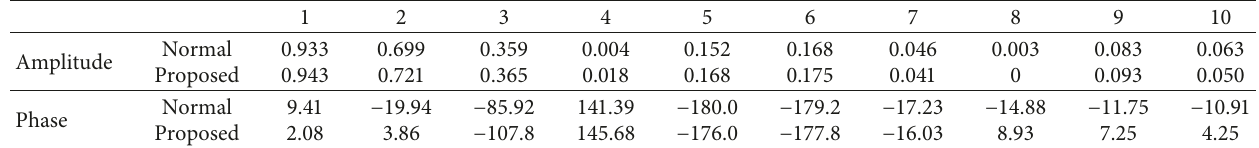
Figure 7: Comparison of convergence curves between the normal method and proposed Taguchi method. (a) Total process. (b) Interval 1 (from step 25 to 35). (c) Interval 2 (from step 50 to 60). Table 3: Amplitudes and phase of optimal results of the arrays with flat top beam (unit of phase: degree).